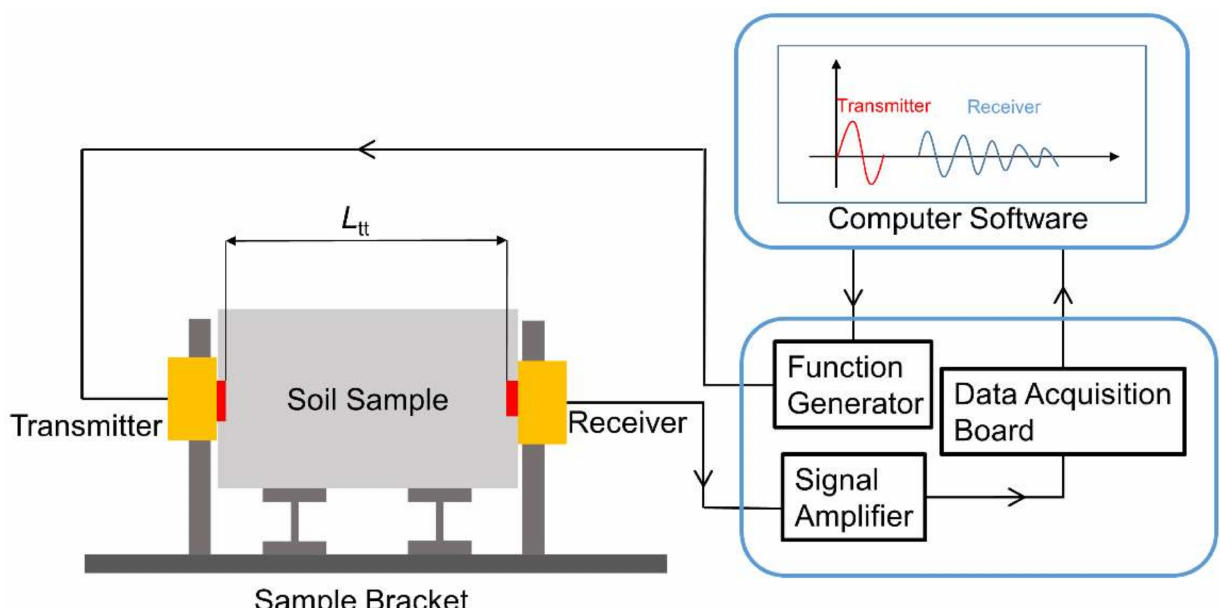
Figure 3. Arrangement of the bender element